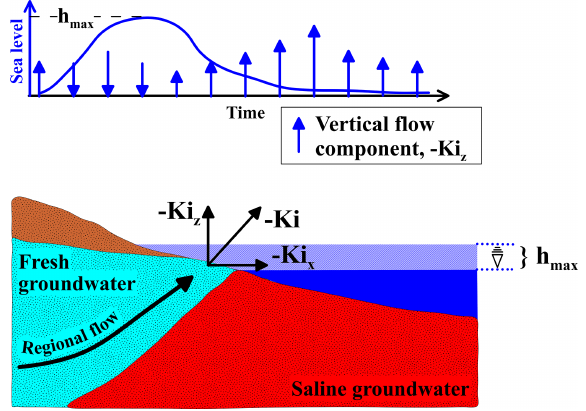
Figure 1. A hypothetical coastal hydrogeological system. Regional fresh (light blue) groundwater flows to the sea and upward due to variable-density flow along the freshwater–saltwater (red) interface. In the nearshore area, focused groundwater discharge occurs either into the sea (blue) or along a seepage face onshore. As shown at the top of the figure, when the surge begins, the direction of flow reverses (infiltration), and when the sea level reaches its maximal level ( h max ), the surge retreats and the direction reverts back (ex- filtration). The upward (positive vertical component) flow reaches a maximum when the sea level is back to the pre-surge level, before decaying to the steady-state